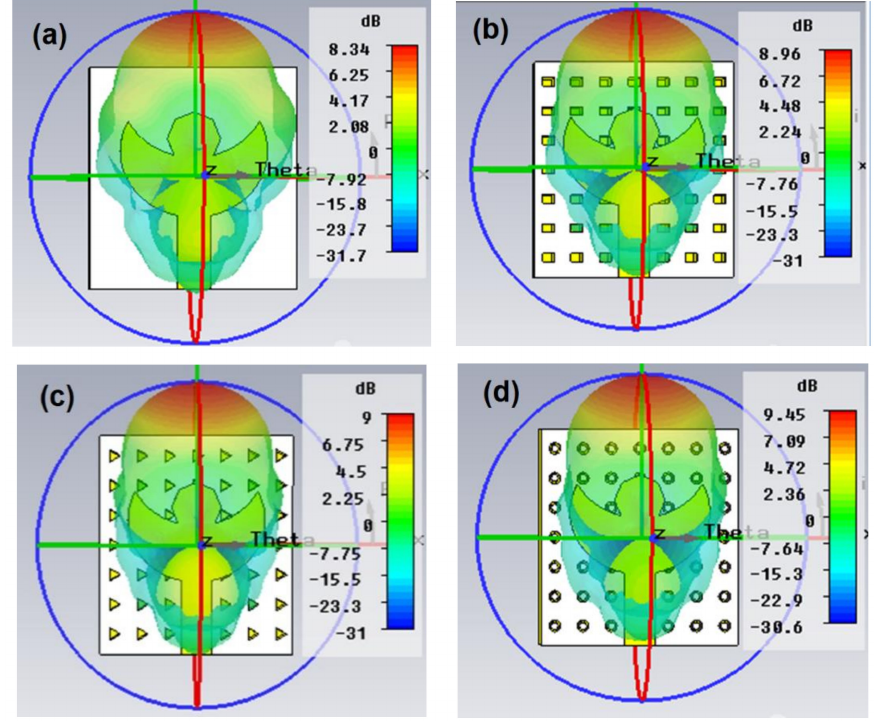
Figure 10. Three-dimensional gain plots of the design antennas ( a ) Type-A antenna ( b ) Type-B antenna ( c ) Type-C antenna ( d ) Type-D antenna.